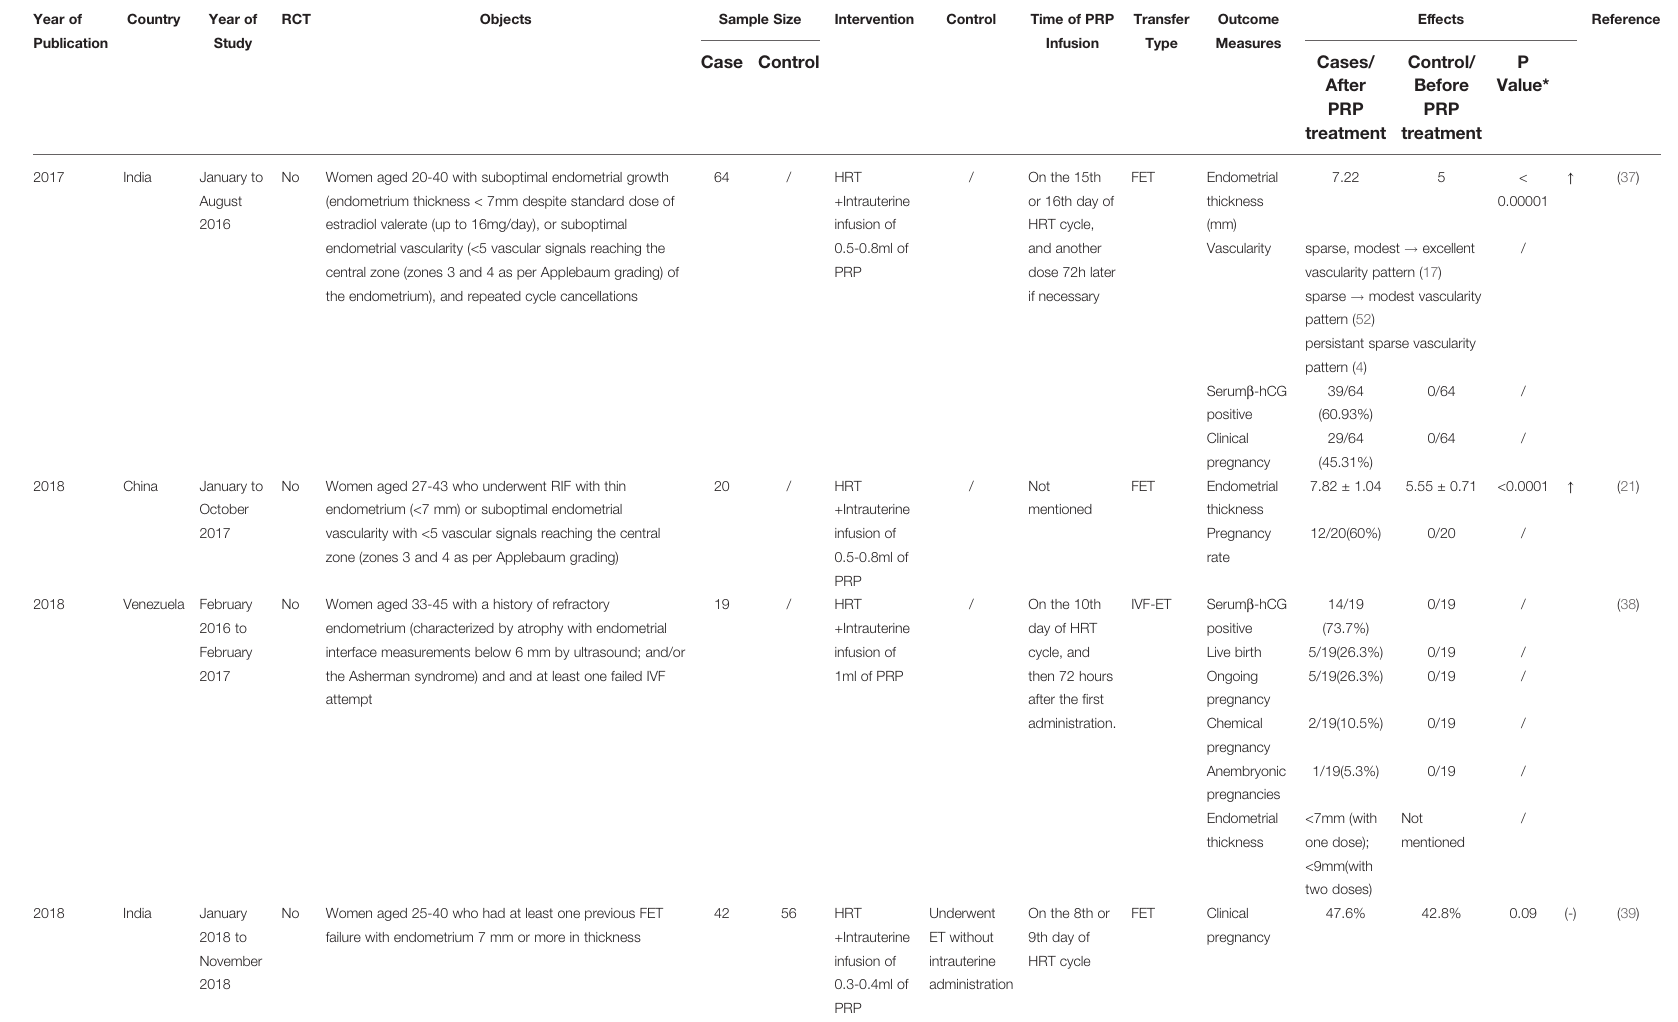
TABLE 3 | Studies assessing the effect of platelet-rich plasma (PRP) treatment in other patients in vitro fertilization. Year of Publication